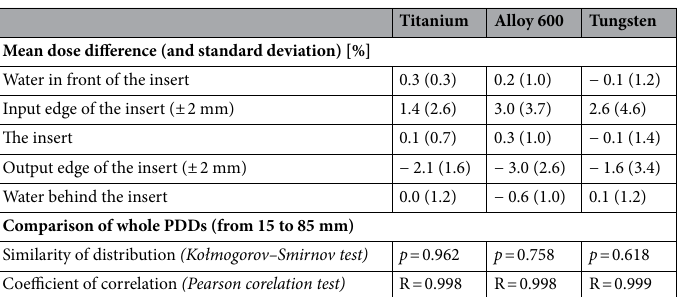
Mean dose difference (and standard deviation)